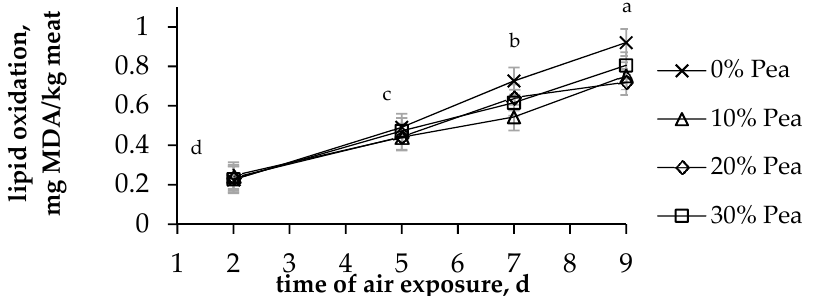
Figure 2. Effect of the proportion of pea in the concentrate on lipid oxidation during air exposure. Vertical bars indicate the standard error of the mean; different letters indicate differences between times ( p < 0.001); MDA: malondialdehyde.